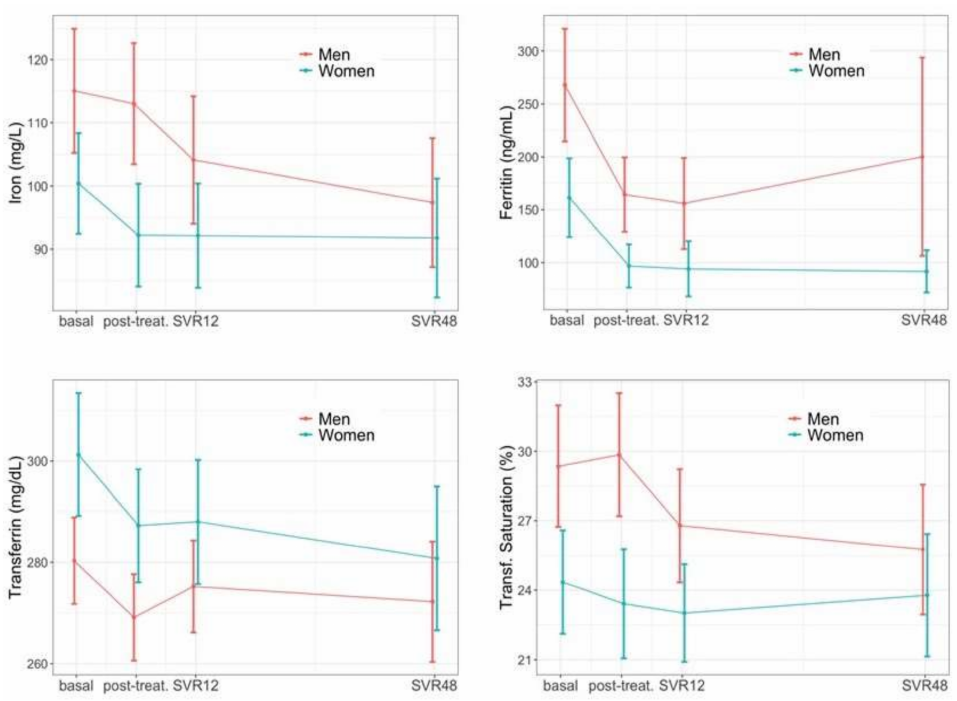
Figure 4. Iron metabolism changes during follow-up. During the follow-up, there was an overall reduction in folic acid (p long = 0.029) and vitamin B12 (p long < 0.001) accompanied by an increase in homocysteine (p long = 0.016). None of these parameters presented sex-specific changes in their longitudinal trajectories (Figure 5).